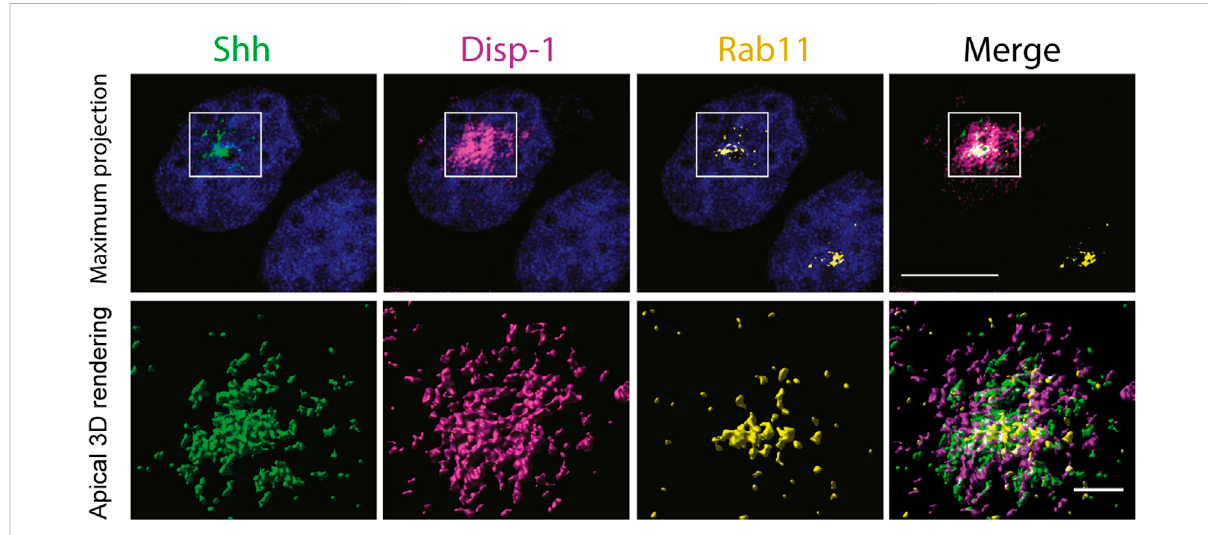
FIGURE 7 High-resolutionimageofsubapicalendosomescontainingShh,Disp-1,andRab11.PolarizedMDCKcellsinglasscoverslipsweremicroinjected to express Shh and Disp-1 for 4h, fi xed, permeabilized, and processed for indirect immuno fl uorescence of Rab11 (yellow), Shh (green), and Disp-1 (magenta), and 12 confocal images of 100 nm thickness were acquired at the subapical region that include the Rab11 compartment. Deconvolved images are shown as maximum projections (upper panels) and as surface 3D-rendered reconstruction of apical planes (lower